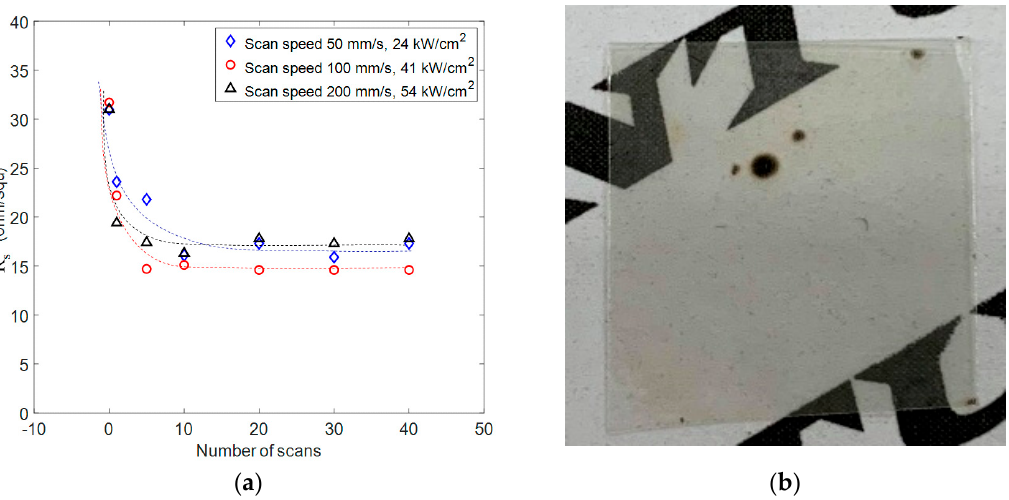
Figure 6. ( a ) Sheet resistance decreased then kept constant as number of scans increased at various scan speed. ( b ) A picture of damaged AgNWs film on PET. The dark spots were the damaged part of PET film at high laser power